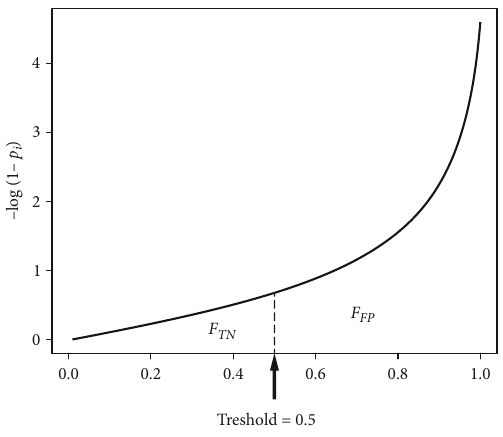
Figure 5. Cost loss function graph for y i =